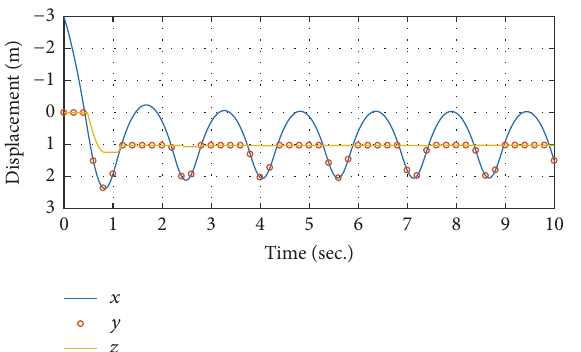
Figure 15: Time history of displacements in elastoplastic system shown in Figure 6.